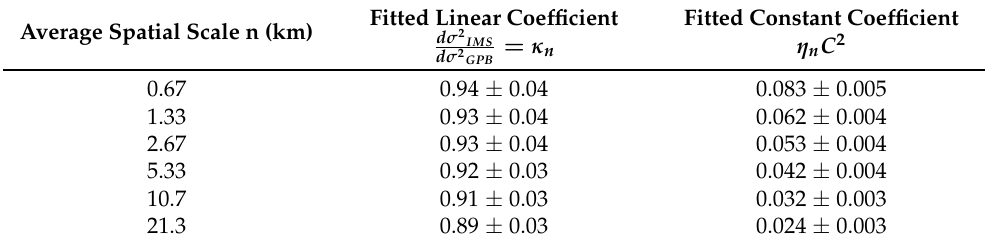
Table 4. Fitted variability contributions to IMOS Multi-sensor L3S climatology anomalies that were reflected in Geo-Polar Blend L4 climatology anomalies. The linear coefficient is approximated by unity to within